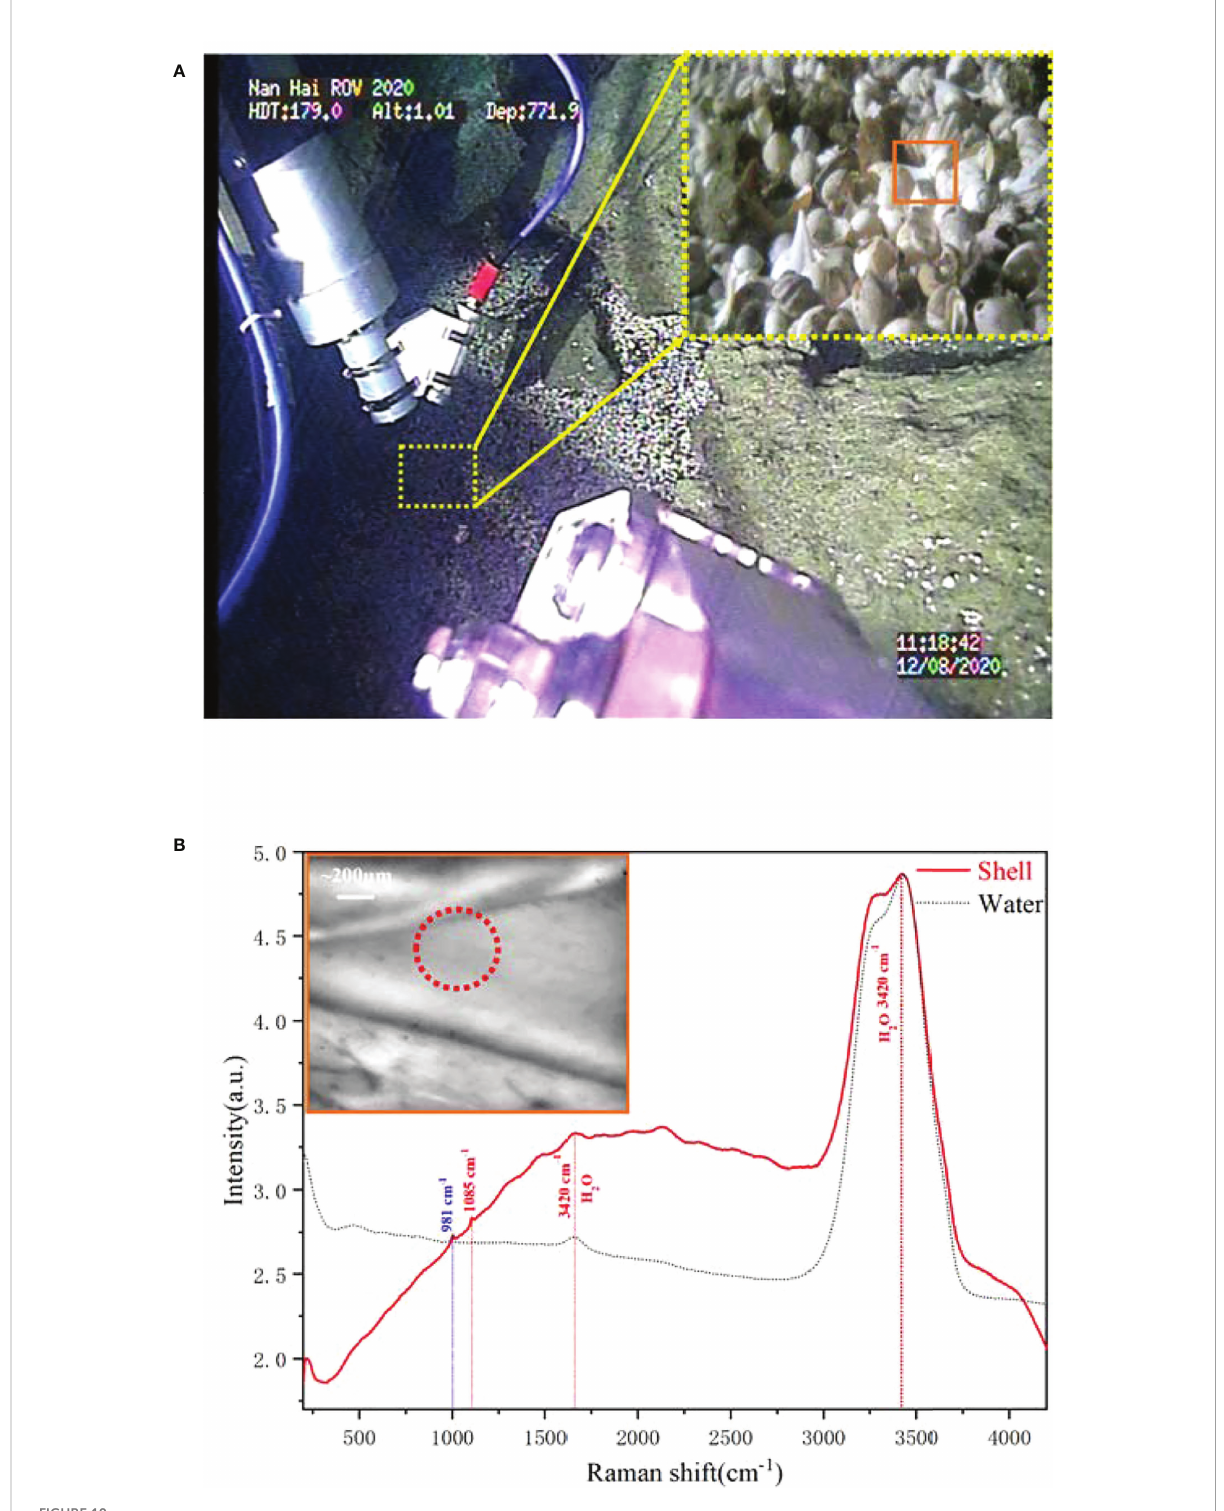
FIGURE 10 The in situ Raman detection and microimaging of deep-sea brachiopods shell. (A) The scenario of deep-sea in situ imaging and detection. (B) The Raman spectra of deep sea brachiopods